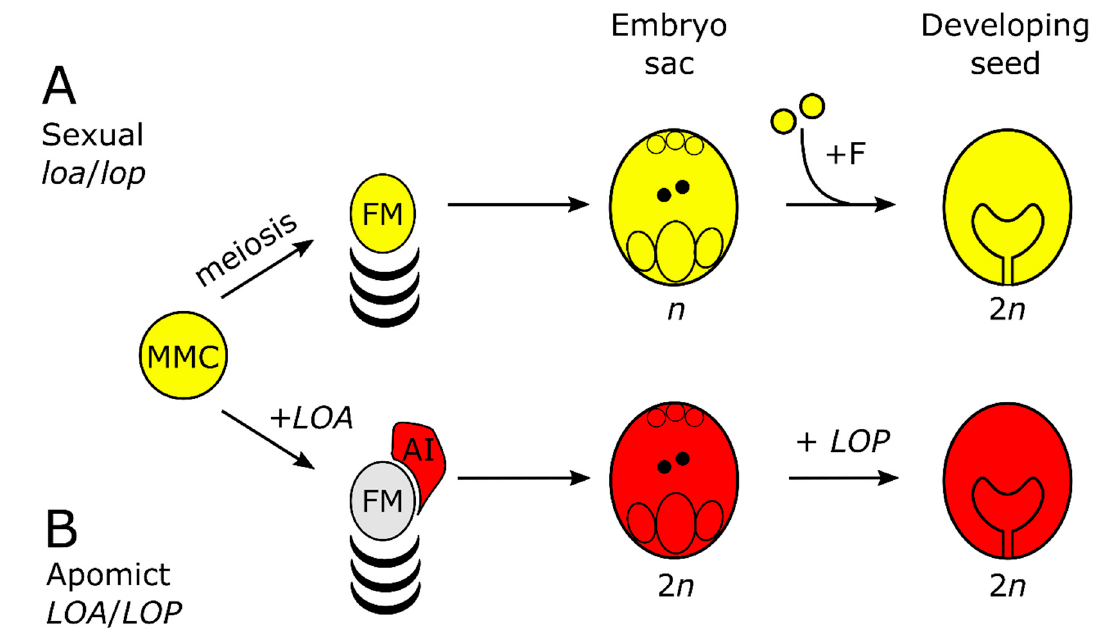
Figure 1. Simplified schematic of sexual and apomictic reproduction in Hieracium subgenus Pilosella ( A ) The sequence of events in sexual Hieracium pilosella indicated in yellow. MMC indicates megaspore mother cell, +F = fertilization, FM = functional megaspore; ( B ) events of apomixis (red) in Hieracium praealtum (R35) and events controlled by activity of the LOSS OF APOSPORY ( LOA ) and LOSS OF PARTHENOGENESIS ( LOP ) loci. AI = aposporous initial cell.